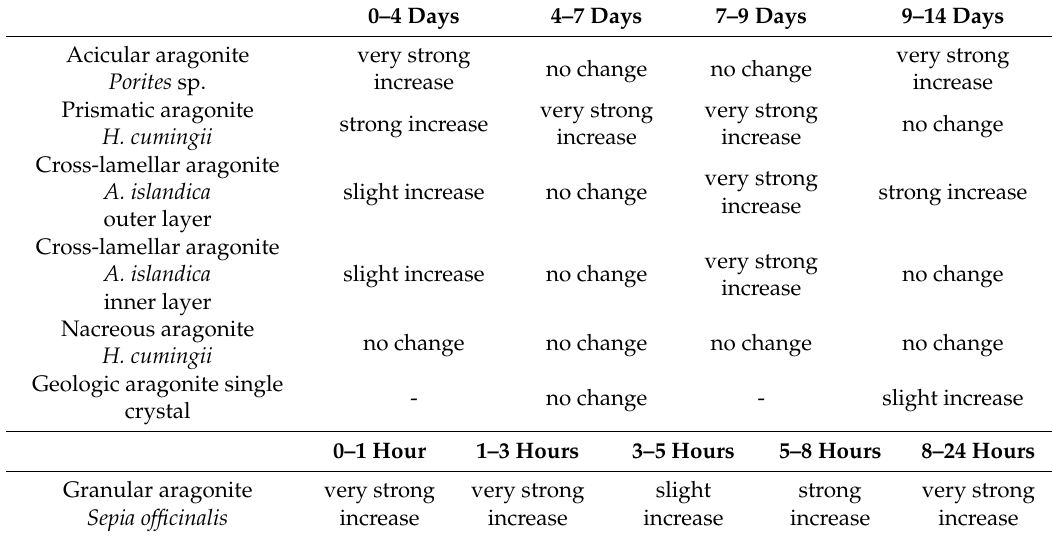
Table 2. Pattern of conversion for the investigated biogenic microstructures and for non-biological aragonite at different conversion